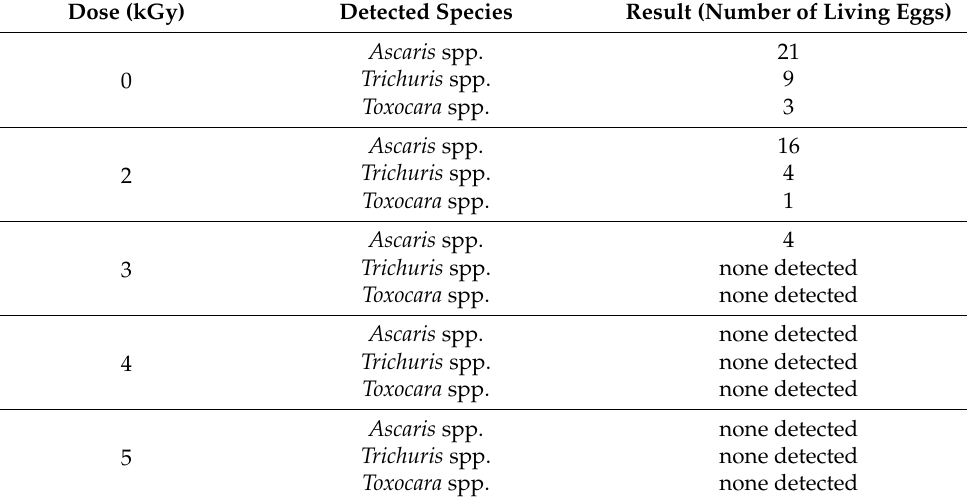
Table 4. Results of the analysis for presence of living eggs of helminths: Toxocara spp., Trichuris spp. and Ascaris spp. in preliminary sewage sludge from WWTP 1.